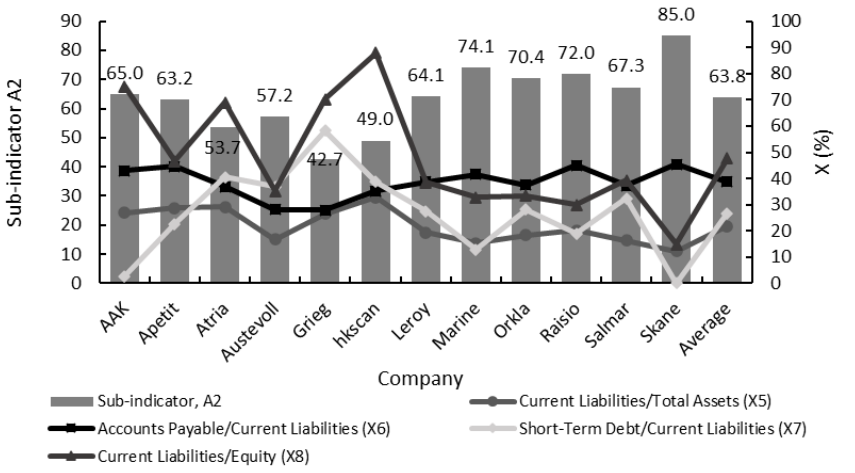
Fig. 5. The average values of components of the sub-indicator of current liabilities (A2) of food companies from Northern Europe in